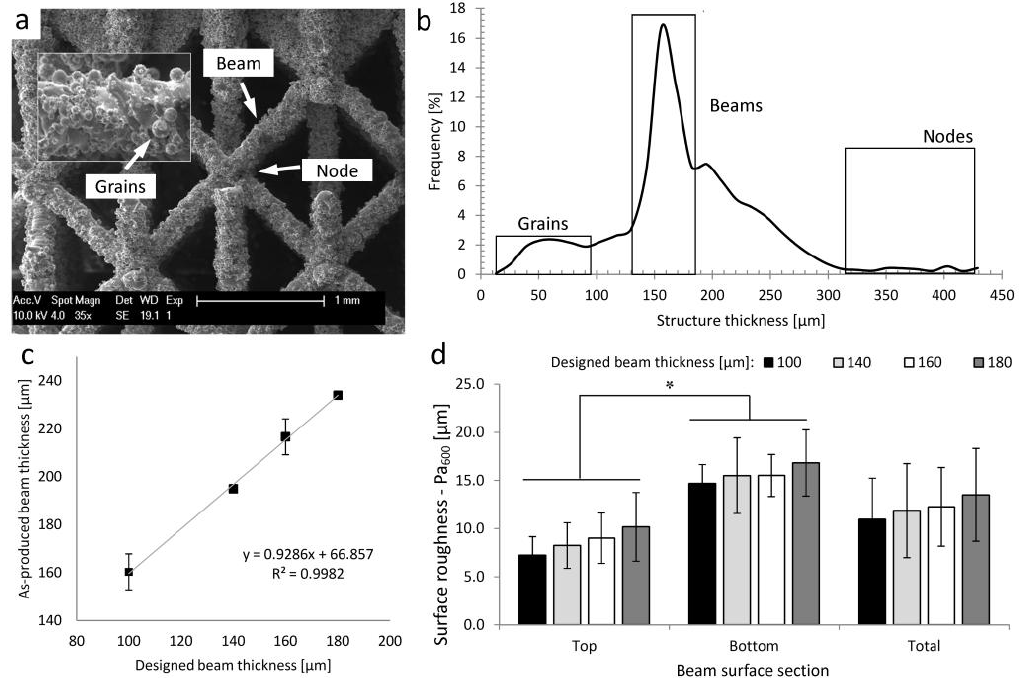
Figure 1. ( a ) A typical scanning electron microscopy (SEM) micrograph of a selective laser melting (SLM)-Ti6Al4V open porous structures with a designed beam thickness of 100 μm (s.100ap-ref), showing its complex morphology and ( b ) the structure thickness distribution of the s.100ap-ref (the left box in the distribution plot represents the grain thickness, the middle box, the beam thickness and the right box, the node thickness). The morphological parameters of the as-produced SLM-Ti6Al4V structures for the four designs, calculated using micro-CT images: ( c ) the designed and as-produced beam thickness and ( d ) the beam surface roughness, P a600